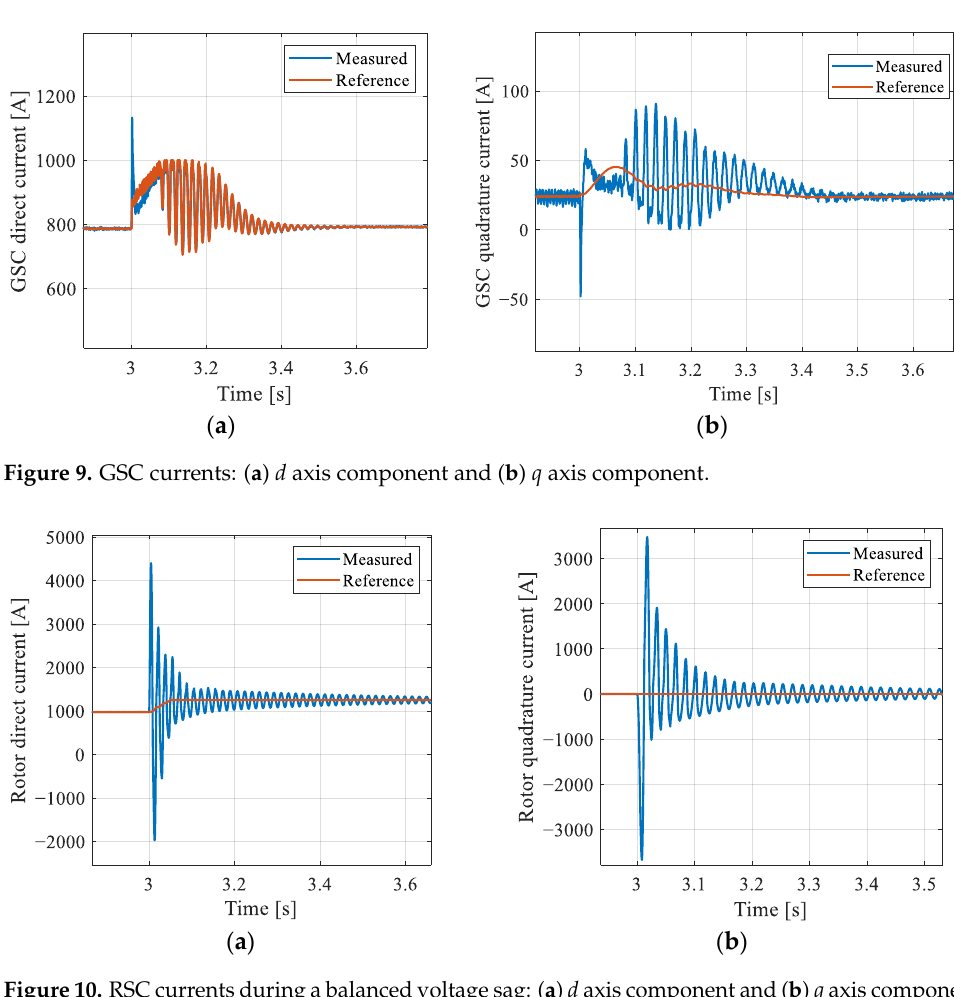
Figure 10. RSC currents during a balanced voltage sag: ( a ) d axis component and ( b ) q axis compo- nent.